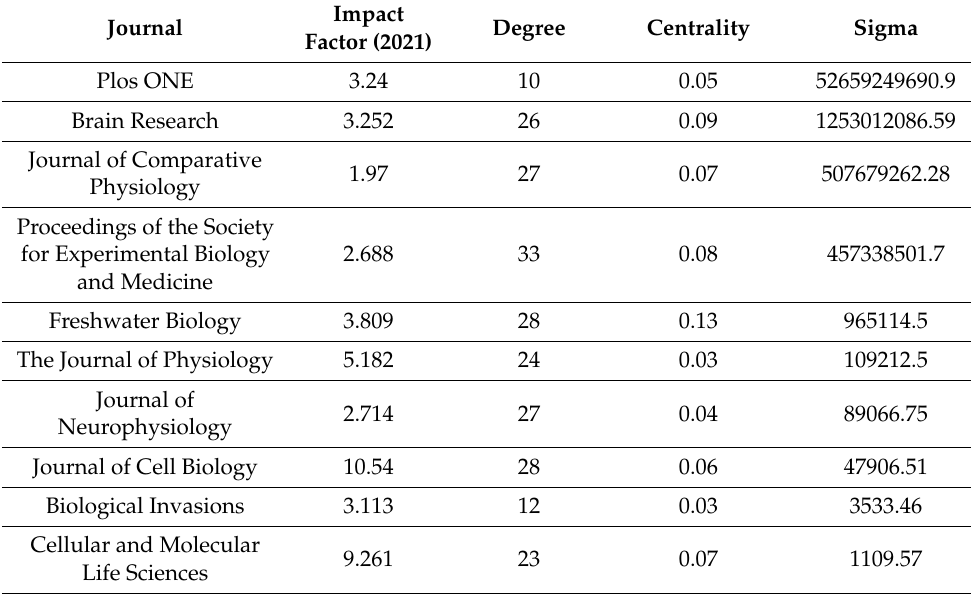
Table 6. Top 10 journals according to co-citation